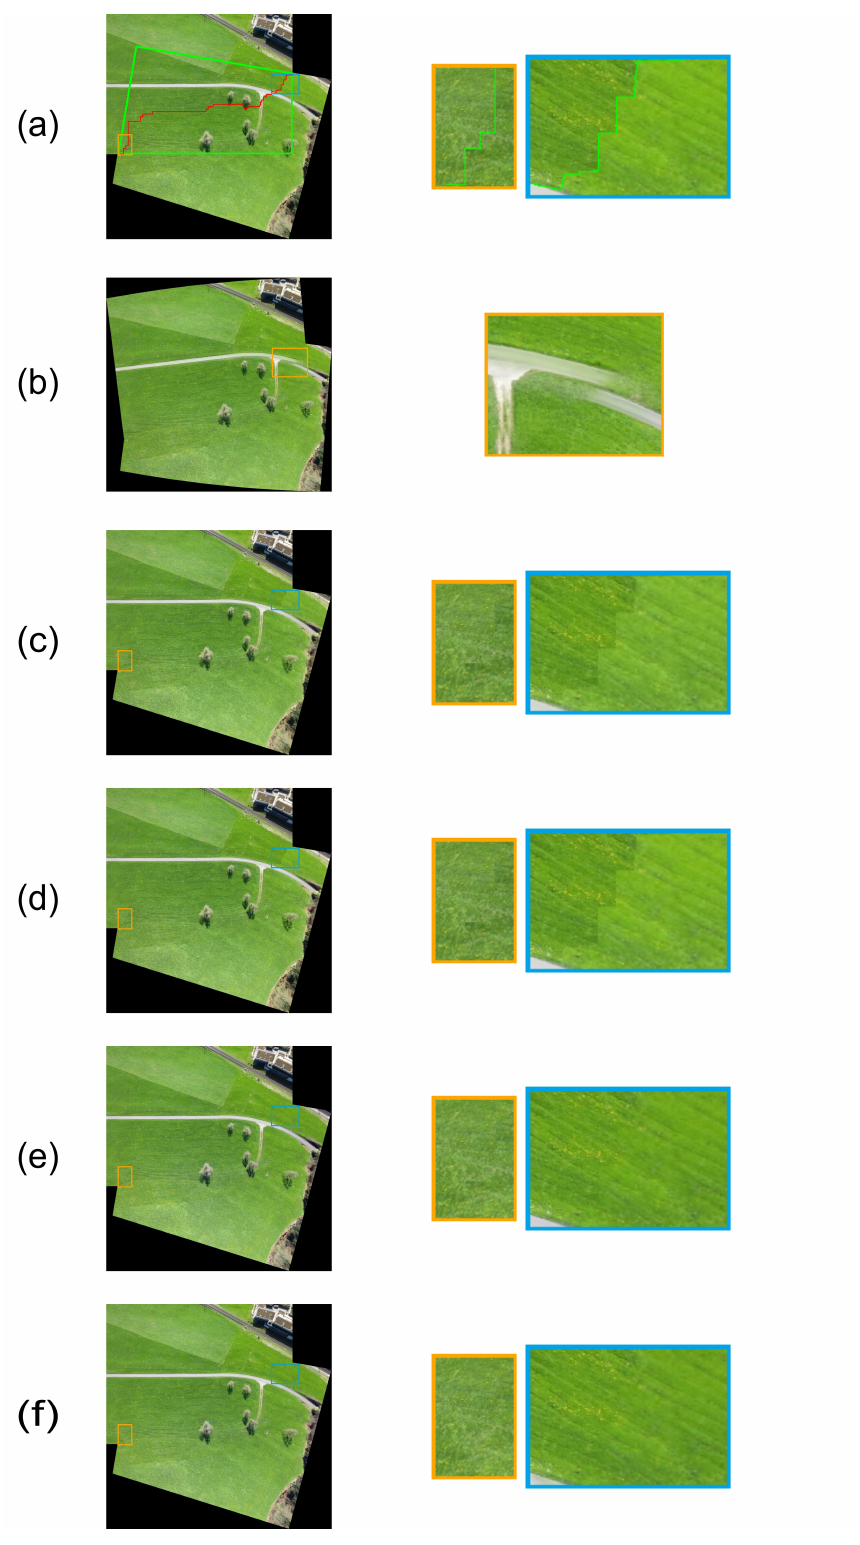
Figure 10. The perceptual quality merit of our method for the third testing stitched image taken from S 1 under +15% brightness update. ( a ) The testing stitched image and the amplified sub-images near the stitching line. ( b ) The MBB method [18]. ( c ) The HM-based method [19]. ( d ) The GP-based method [21]. ( e ) The GBJI-based method [23]. ( f ) Our